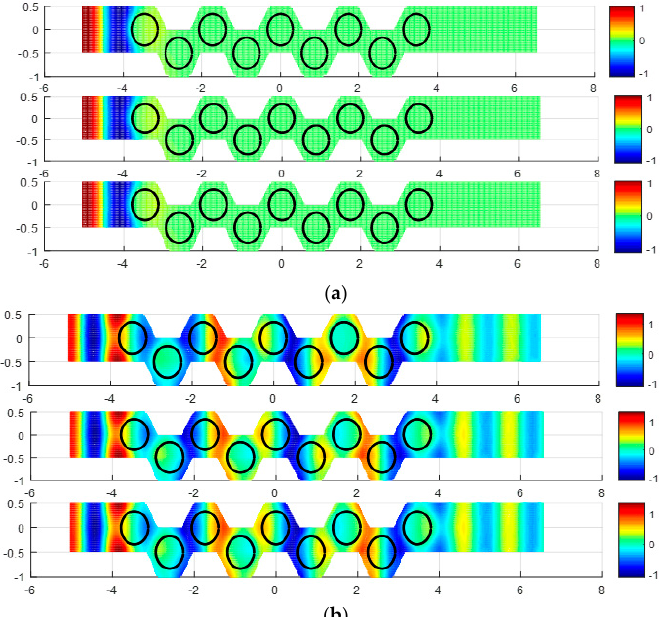
ω a = in the bandgap re- 0.5 π 2 c 0 = 0.9 in the pass band 2 π c 0